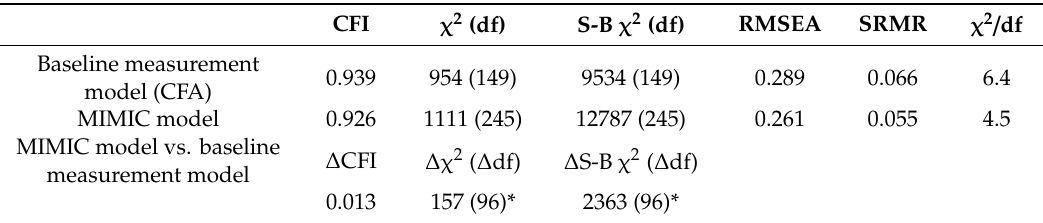
Table 4. Goodness-of-fit statistics for the MIMIC model. Statistically significant parameters at the 5% level or better are marked with